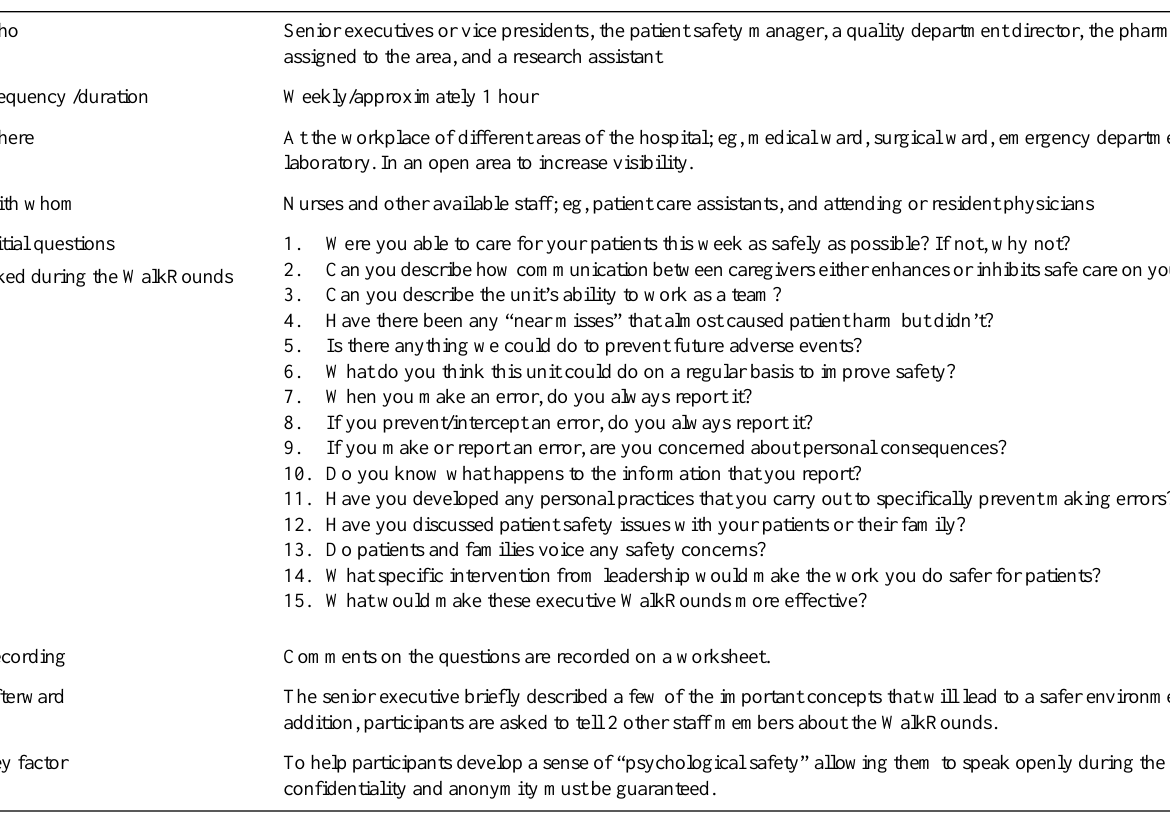
Table 2. Original concept of WalkRounds. a